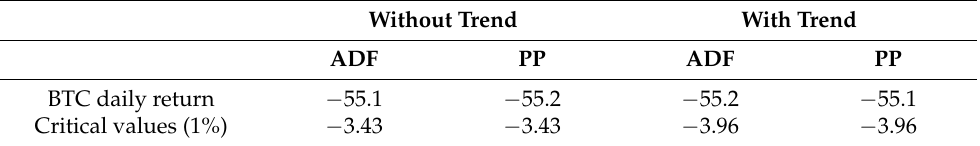
Table 2. Unit Root Tests.